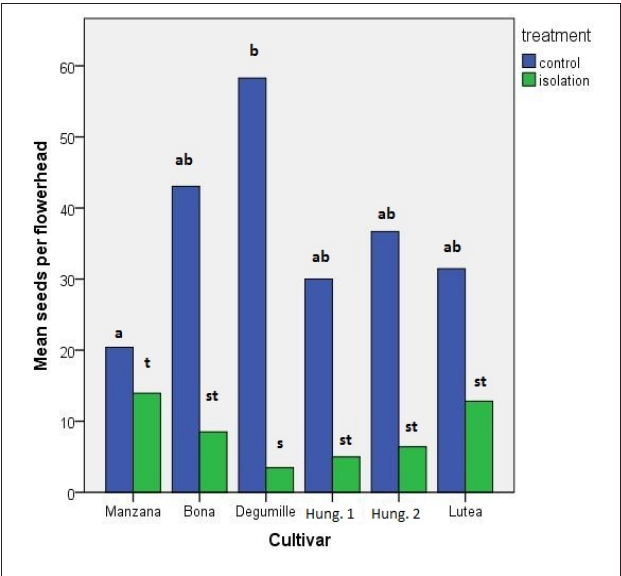
Fig. 1: Comparison of seed production between cultivars/varieties and treatments, different letters indicate statistical difference at the p < 0.05 level